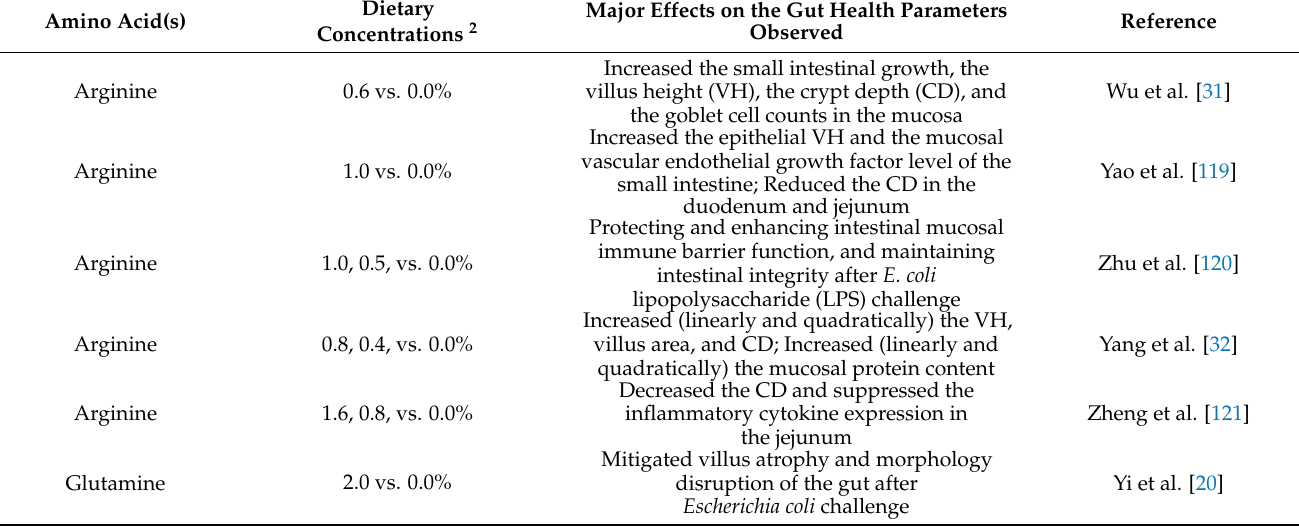
Table A1. An overview of the research during the last two decades concerning the effects of dietary amino acids on gut health and functions in weanling pigs 1